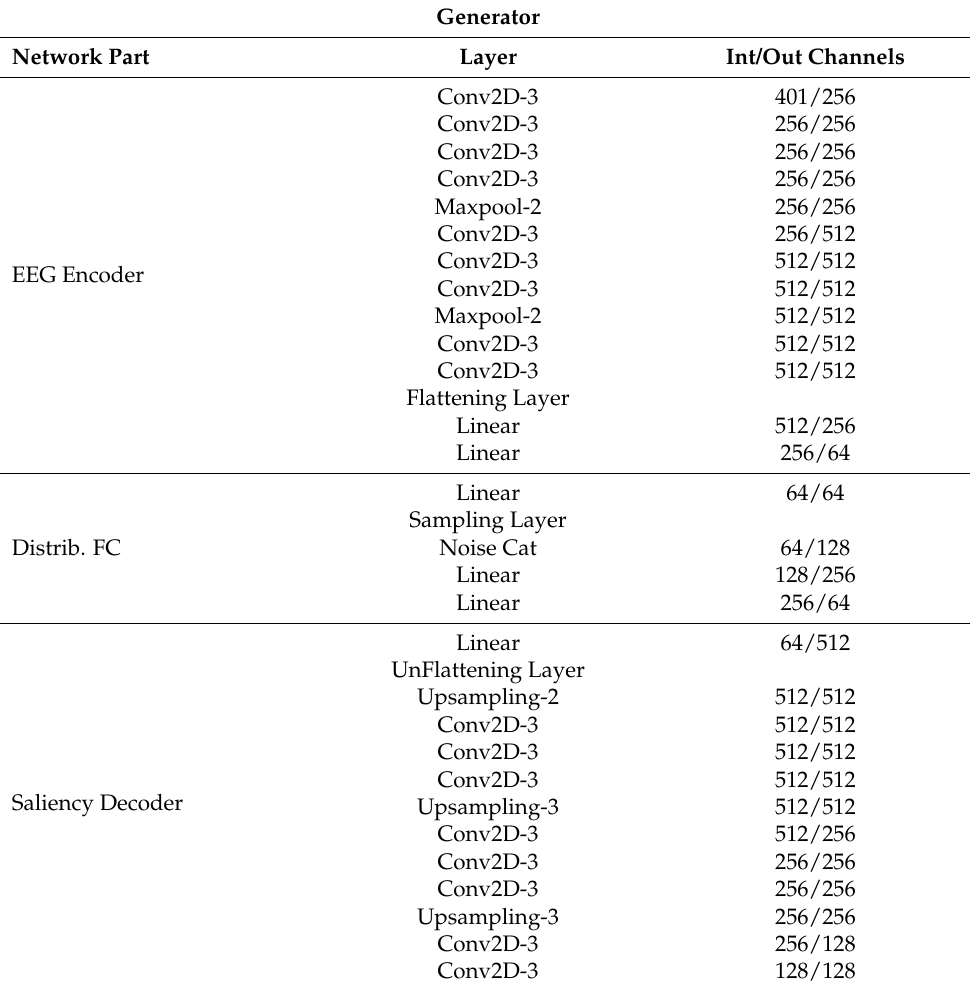
Table 1. Architecture of the generator